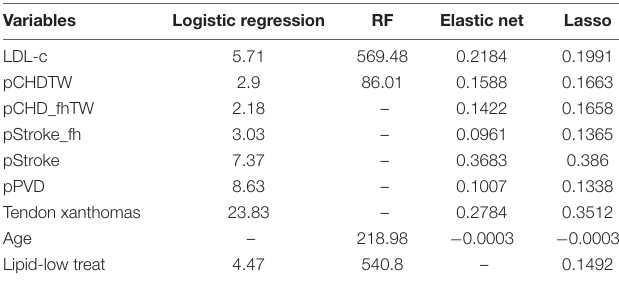
TABLE 4 | The nine variables for machine learning (ML) model